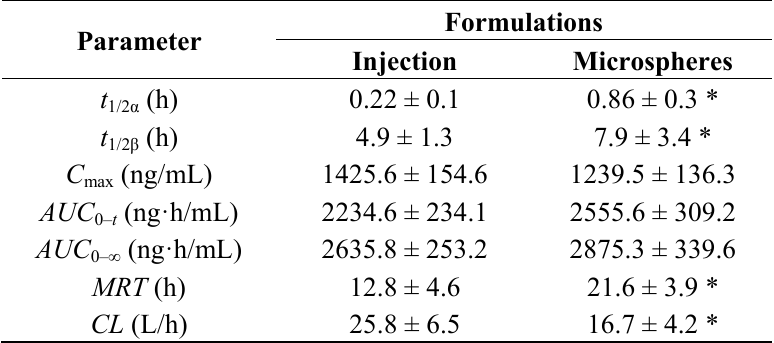
Table 2. Pharmacokinetic parameters of the two